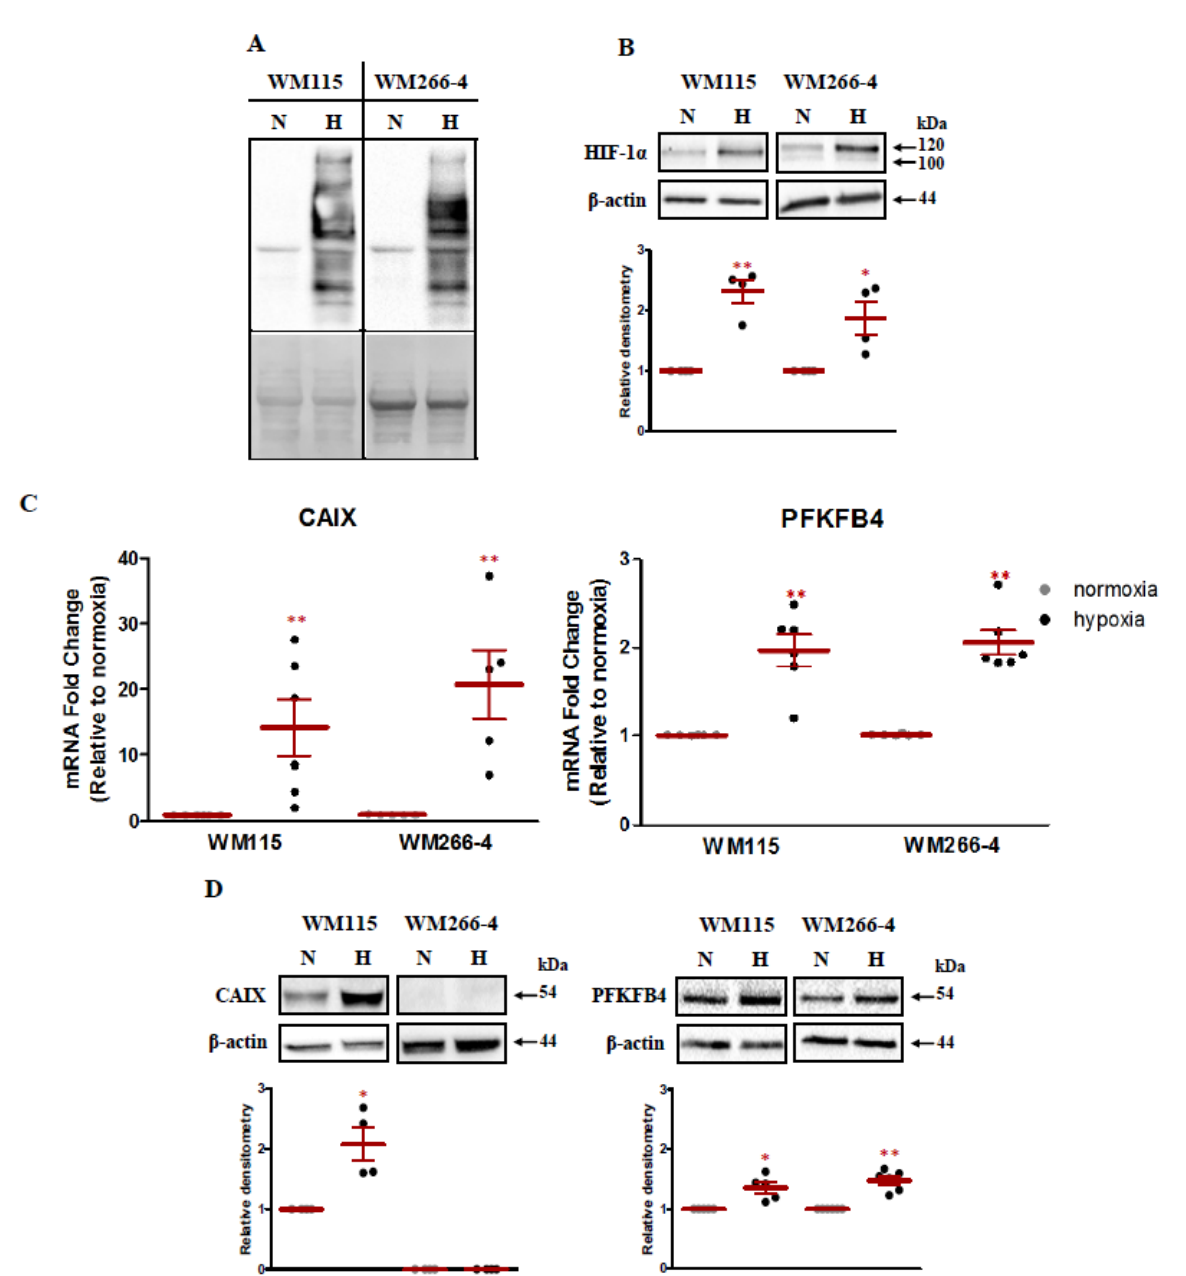
Figure 1. The response of malignant melanoma cells to low oxygen concentration. ( A ) Upper panel: Malignant melanoma lines, WM115 and WM266-4, were cultured with 100 µ M pimonidazole (hypoxyprobe) in normoxic (N) and hypoxic conditions (H) for 16 h. The formation of pimonidazole–protein adducts were detected using Western Blot. Lower panel: Ponceau S stained membrane is shown as an internal control for equal protein loading. ( B ) Upper panels: Melanoma cells were cultured for 16 h in normoxia and hypoxia. Then HIF-1 alpha subunit accumulation was verified using the Western Blot. β -actin is shown as an internal control for equal loading. Lower panels: Densitometry analysis of Western Blot bands intensity normalized to β -actin. Relative densitometry value is the average of four independent experiments. The mean ± SEM is shown. Student’s t- test was used to evaluate the influence of hypoxia on HIF-1 alpha subunit stabilization. * p < 0.05 by Student’s t- test, ** p < 0.01 by Student’s t- test, p -value between 0.05 and 0.1 by Student’s t- test was given as an indication of the trend. ( C ) CAIX and PFKFB4 expression was analyzed by RT-qPCR in both melanoma cell lines under hypoxic and normoxic conditions. Expression data for each transcript was normalized to that for the reference gene TBP. Means ± SEM of at least five independent experiments are presented relative to expression in normoxic controls. The Student t- test was used to evaluate the differences between normoxic and hypoxic expression of CAIX and PFKFB4 . ** p < 0.01 by Student’s t- test. ( D ) Upper panels: Melanoma cells were cultured for 16 h in normoxia and hypoxia. Then CAIX